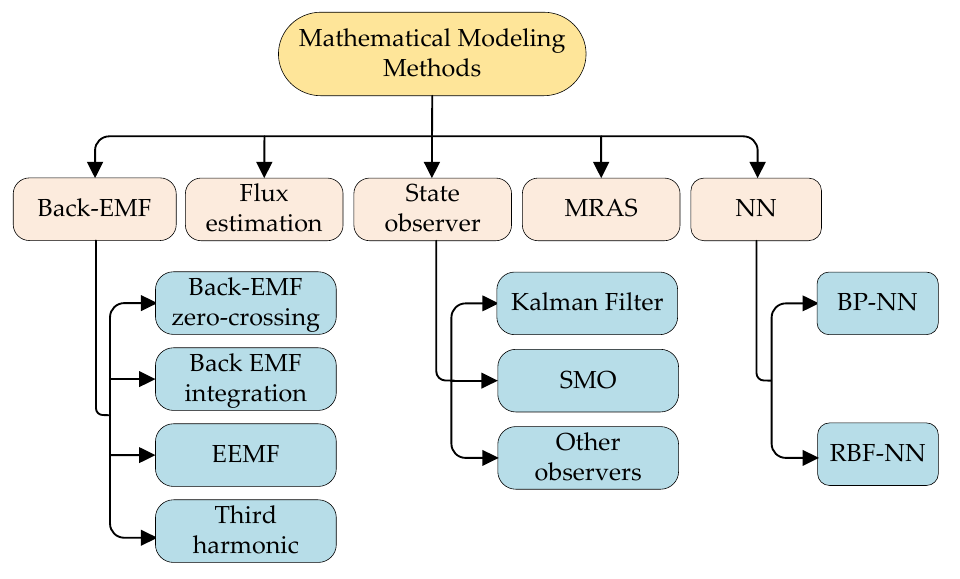
Figure 6. Sensorless strategies for medium-high speed.